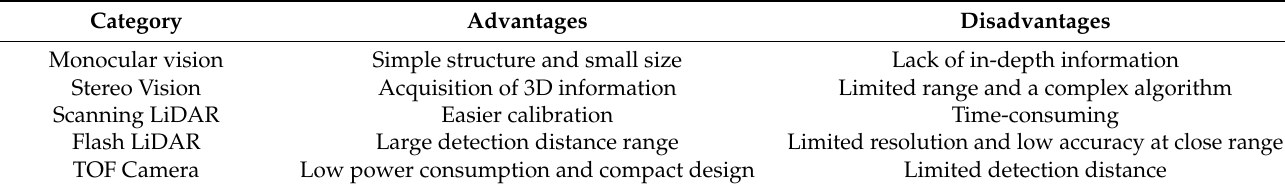
Table 9. Advantages and disadvantages of visual